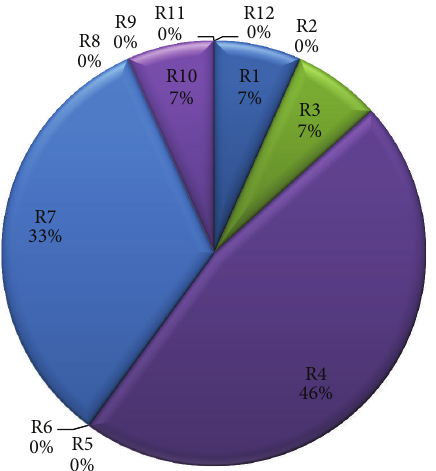
Figure 8: Resource loads for synthetic workflow. Table 3: Improvement for synthetic workflow. Num. of proc.